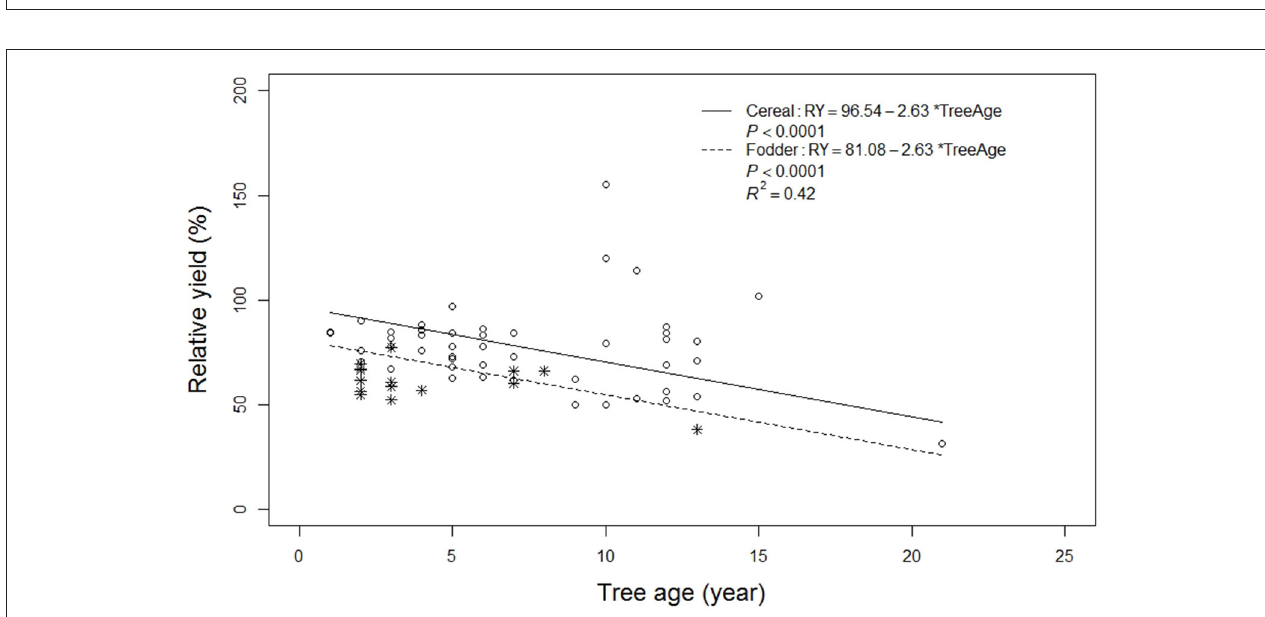
FIGURE 6 | Plot of relative crop yields against tree age for cereals (black) and fodder crops (red) in alley cropping trials. A mixed effects model using a common slope was fitted to the data: RY ij = β 0 + β 1* TreeAge ij + β 2* Intercrop ij + a i + ε ij (Model 5). The symbols distinguish experimental sites of data points.